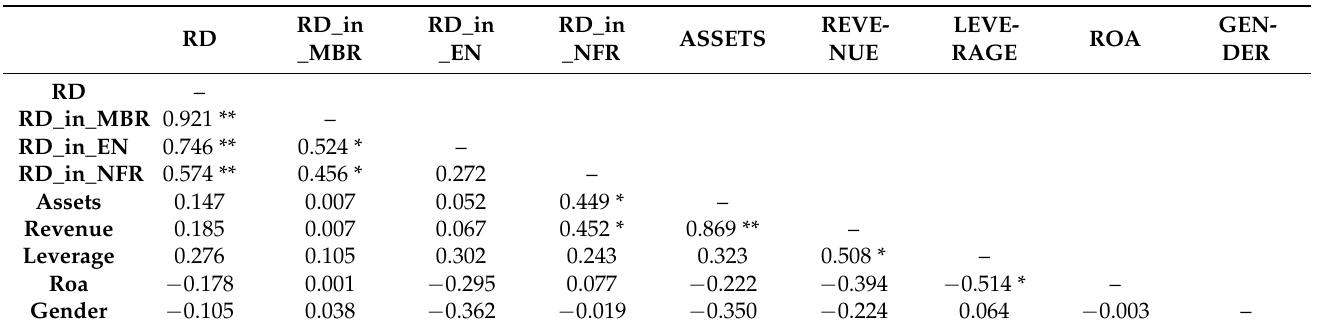
Figure 2. The Structure of Risk Disclosure Information by Companies in 2020. Source: Own elaboration. Table 4. Correlation